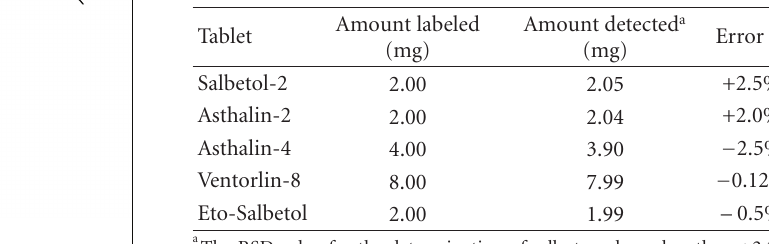
Table 1: Determination of salbutamol in di ff erent pharmaceutical preparations using SWNT/EPPGE.